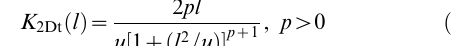
variation in species abundances (B) along the environmental gradient for communities with (CFM-U, and CFM-L) and without (CM) facilitation. The threshold of environmental severity level S m = 0.9, and other parameter values are the same as in Fig. 1. Each data point represents the mean 6 SE. Figure S2 The relationship between the coefficient of variation in species abundances and the Bray-Curtis similarity index for communities with (CFM-U, and CFM-L) and without (CM) facilitation. The threshold of environmental severity level S m =0.9, and other parameter values are the same as in Fig. 1. Each data point represents the mean 6 SE. The R 2 of the quadratic regression is 0.9395. Figure S3 The Bray-Curtis similarity (A) and the coefficient of variation in species abundances (B) along the environmental gradient for communities with (CFM-U, and CFM-L) and without (CM) facilitation. The facilitative coefficient f =0.3, and other parameter values are the same as in Fig. 1. Each data point represents the mean 6 SE. Figure S4 The relationship between the coefficient of variation in species abundances and the Bray-Curtis similarity index for communities with (CFM-U, and CFM-L) and without (CM) facilitation. The facilitative coefficient f = 0.3, and other parameter values are the same as in Fig. 1. Each data point represents the mean 6 SE. The R 2 of the quadratic regression is 0.9230. Figure S5 The Bray-Curtis similarity (A) and the coefficient of variation in species abundances (B) along the environmental gradient for communities with (CFM-U, and CFM-L) and without (CM) facilitation. The regional species pool R = 100, and other parameter values are the same as in Fig. 1. Each data point represents the mean 6 SE. Figure S6 The relationship between the coefficient of variation in species abundances and the Bray-Curtis similarity index for communities with (CFM-U, and CFM-L) and without (CM) facilitation. The regional species pool R = 100, and other parameter values are the same as in Fig. 1. Each data point represents the mean 6 SE. The R 2 of the quadratic regression is 0.9274. Figure S7 The Bray-Curtis similarity (A) and the coefficient of variation in species abundances (B) along the environmental gradient for communities with (CFM-U, and CFM-L) and without (CM) facilitation. The immigration rate I = 20, and other parameter values are the same as in Fig. 1. Each data point represents the mean 6 SE. Figure S8 The relationship between the coefficient of variation in species abundances and the Bray-Curtis similarity index for communities with (CFM-U, and CFM-L) and without (CM) facilitation. The immigration rate I = 20, and other